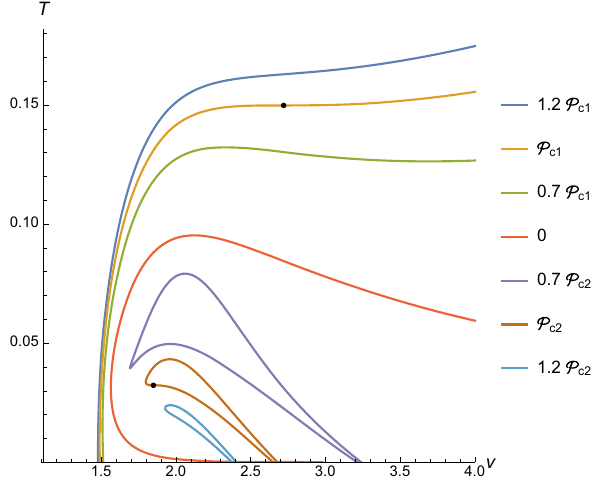
Fig. 3 T – v diagram of dilatonic black hole with N = 2 , D = 6. We set the electric charge Q = 10. The two black points represent the critical points